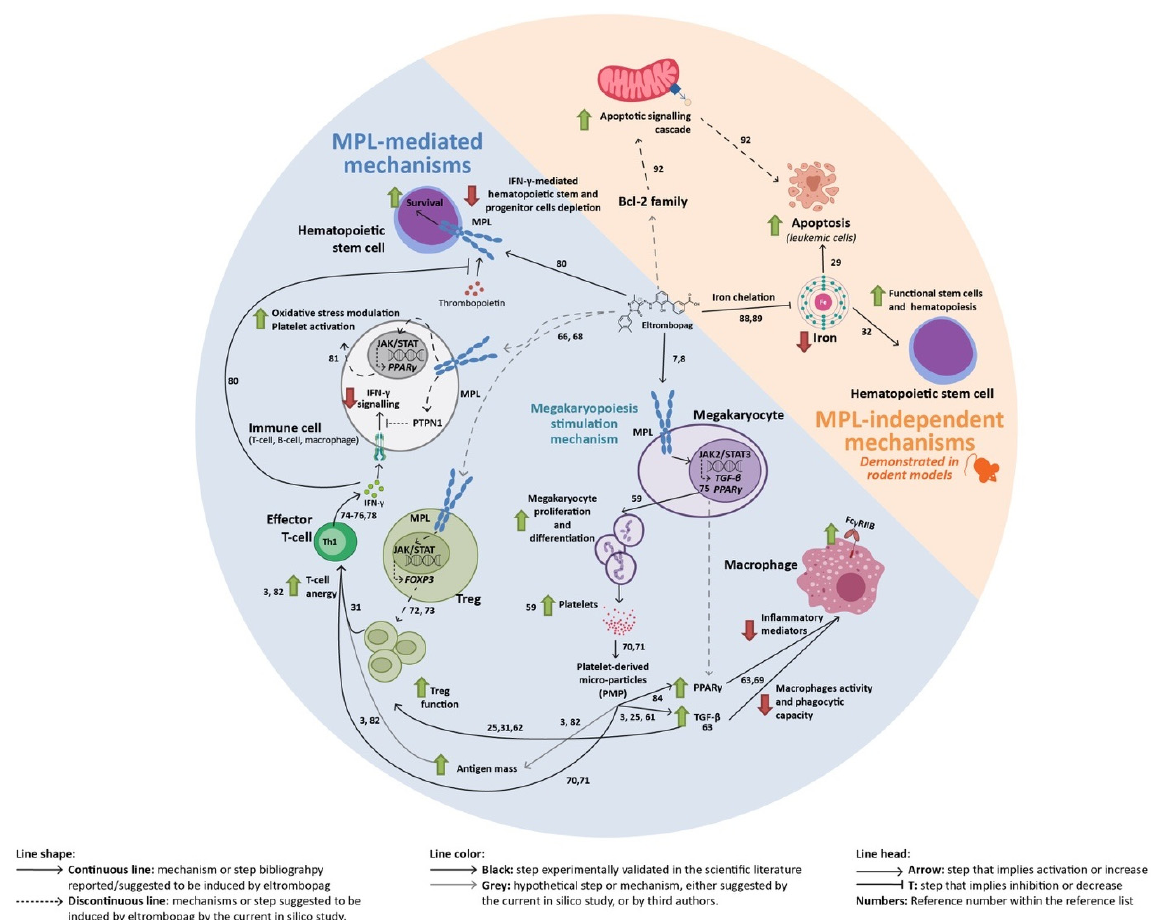
Figure 5. Summary of the immunomodulatory mechanisms described and hypothesized for eltrombopag. Bcl-2: B-cell lymphoma 2; FOXP3: forkhead box protein P3; IFN- γ : interferon-gamma; MPL: thrombopoietin receptor; PMP: platelet-derived microparticles; PPAR γ : peroxisome proliferator-activated receptor gamma; PTPN1: tyrosine-protein phosphatase non-receptor type 1; TGF- β : transforming growth factor beta; Treg: regulatory T cell.